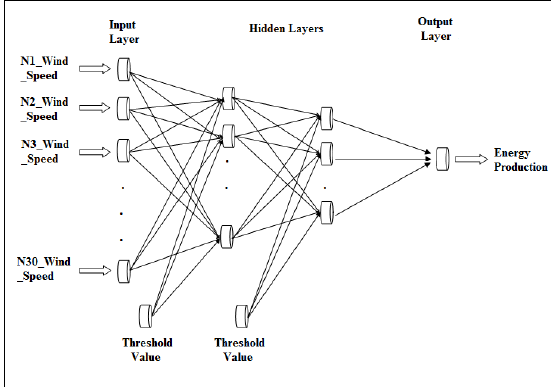
Figure 3. Network topology for the energy production prediction